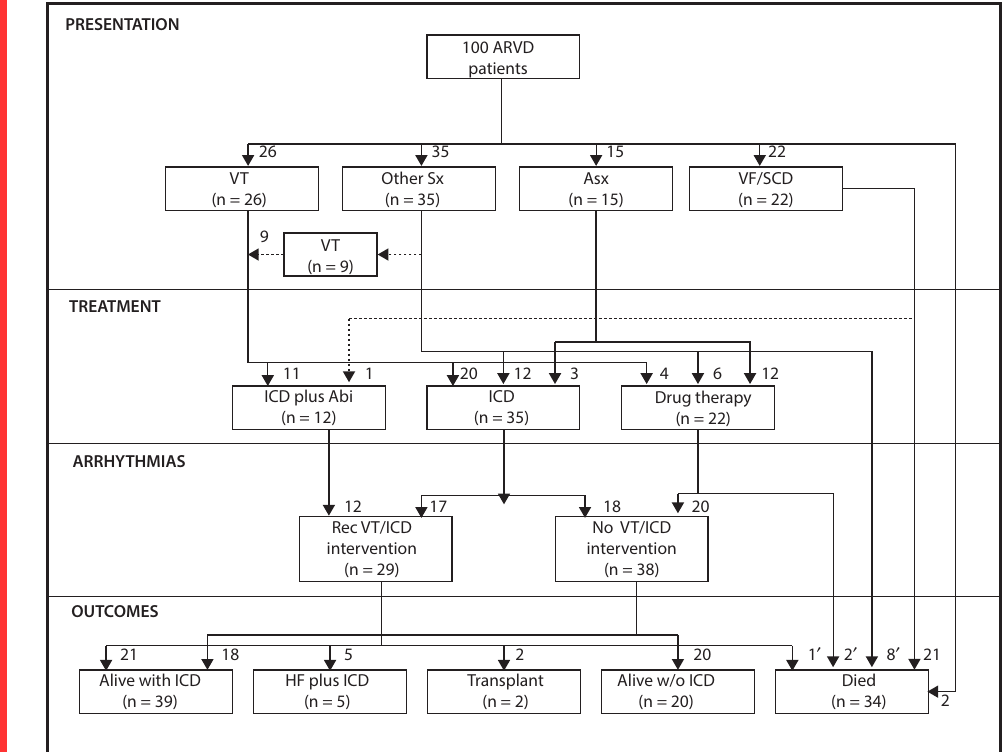
Figure 9. Schematic outline and quantification of the presentation, treatment, arrhythmia, and outcome in the entire patient population in the John Hopkins Registry. Sx indicates symptoms; Asx , asymptomatic; VF , ventricular fibrillation; Abl , catheter ablation of VT; Rec VT , recurrent VT; HF , heart failure; and w/o , without. * These patients died of noncardiac causes of death; autopsy revealed findings consistent with ARVD. †These patients experienced fatal VF leading to SCD; they could not be resuscitated. ‡This patient died because of biventricular heart failure at the age of 27 years; an ICD was in place at the time of death and the patient was awaiting a heart transplant